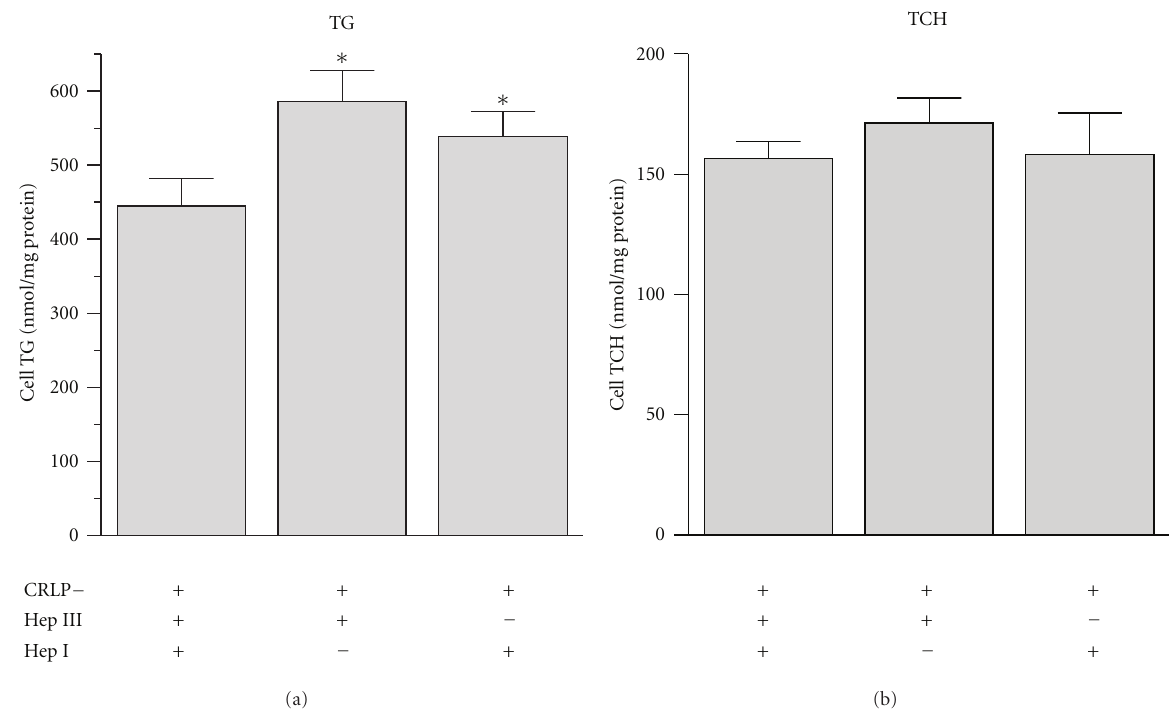
Figure 4: Role of proteoglycan-mediated bridging in macrophage lipid accumulation. HMDM were incubated 1 h in serum-free medium before treatment with 33 U/mL heparinase III (Hep III) or 33U/mL heparinase I (Hep I) in combination with 50mM Na chlorate. Both untreated and treated macrophages were then incubated 24h with 80 μ g cholesterol/mL CRLPw/o. Treatments were continued during the incubations. Macrophage triacylglycerol (TG) and total cholesterol (TCH) contents are reported as nmol/mg protein (means ± SD, n = 4). ∗ P < 0.005 versus